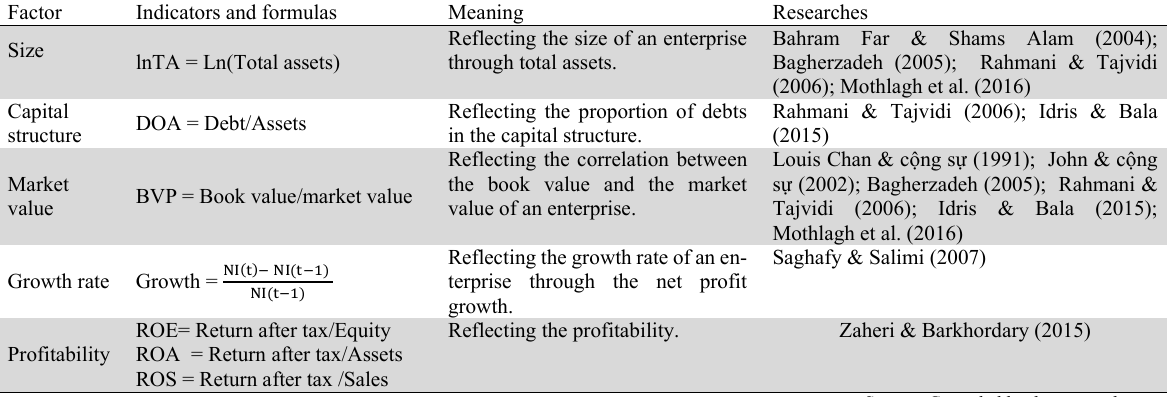
The meaning of independent variables